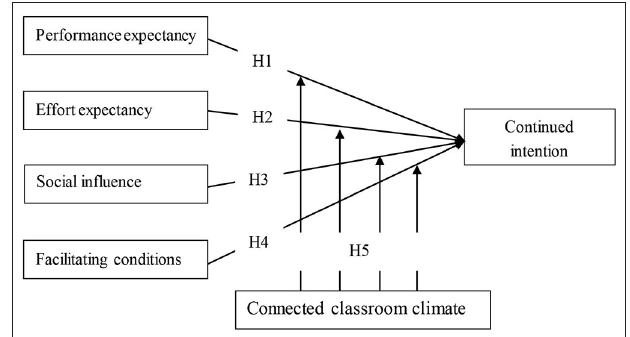
FIGURE 1 | Theoretical model and